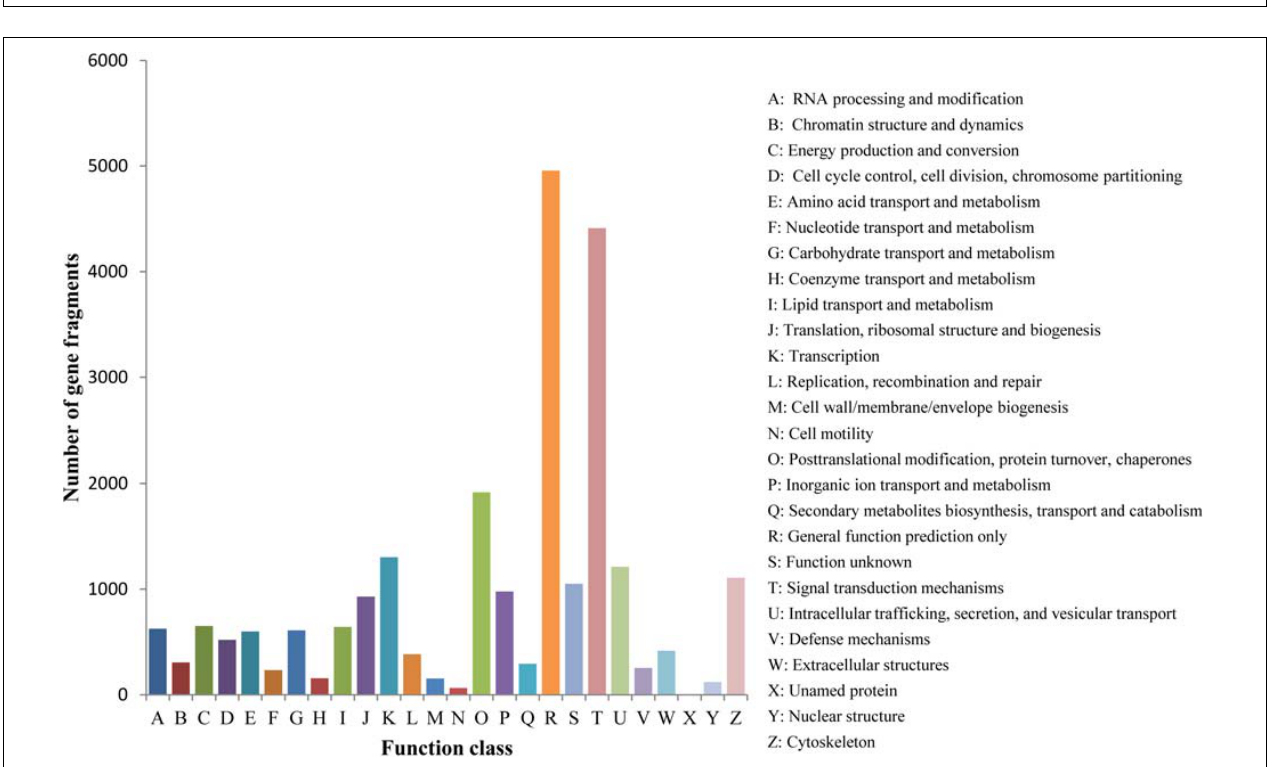
FIGURE 2 | KOG classification of putative Gymnocypris eckloni proteins. The y-axis indicates the number of gene fragments in each functional cluster.